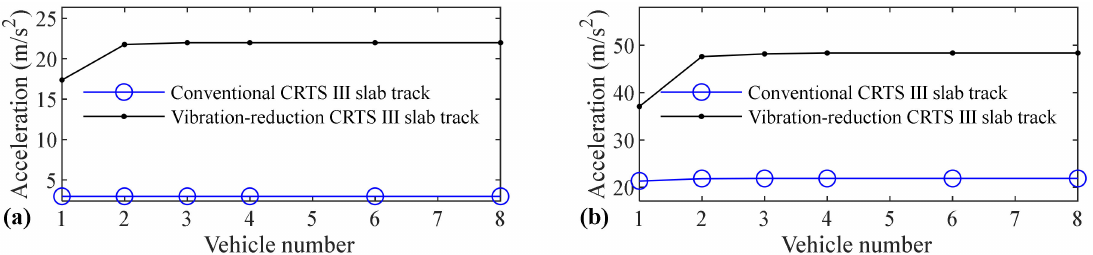
Figure 7. Relation between vehicle number and acceleration of slab: ( a ) without and ( b ) with random track